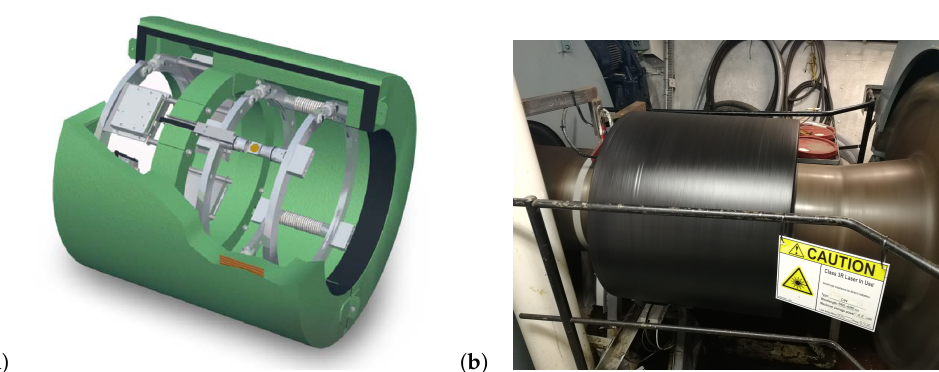
Figure 3. TT-Sense ® sensor: cross-section drawing ( a ); accommodation on the Starboard shaft ( b ).